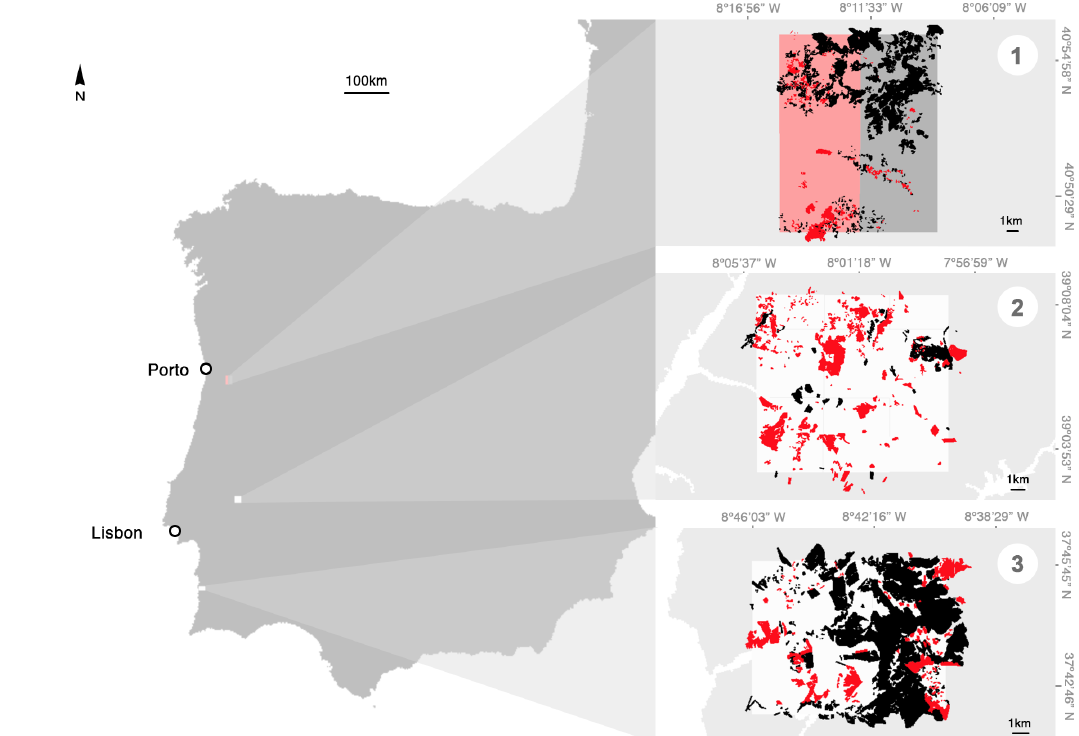
Figure 1. Regions that were selected for training (light red rectangle), validation (gray rectangle) and evaluation (white rectangles) of the model. Site number (1) is located in the Serras da Freita e Arada area, site number (2) in the Cabeção area and site number (3) in the Costa Sudoeste region. The ground truth map for Eucalyptus (black) and Conifers (red) is